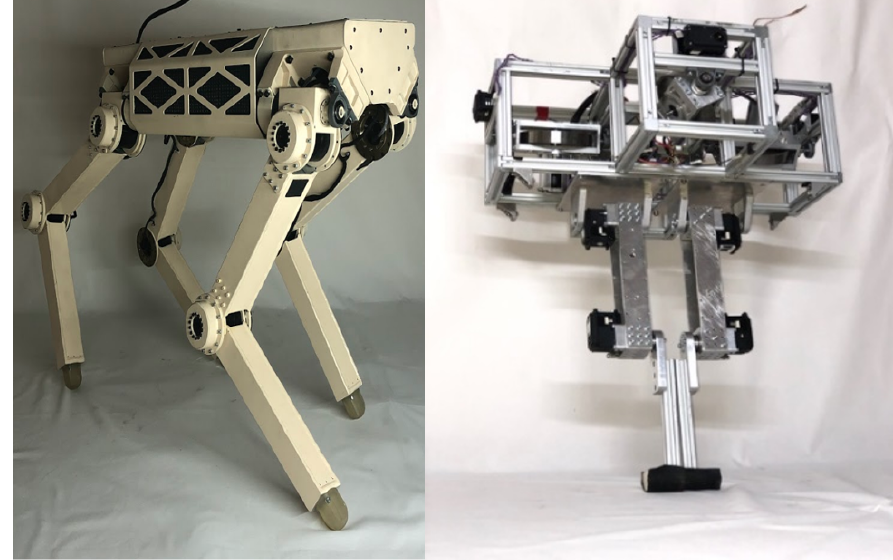
Figure 11. The robots Quadruped ( left ) and RGSS ( right